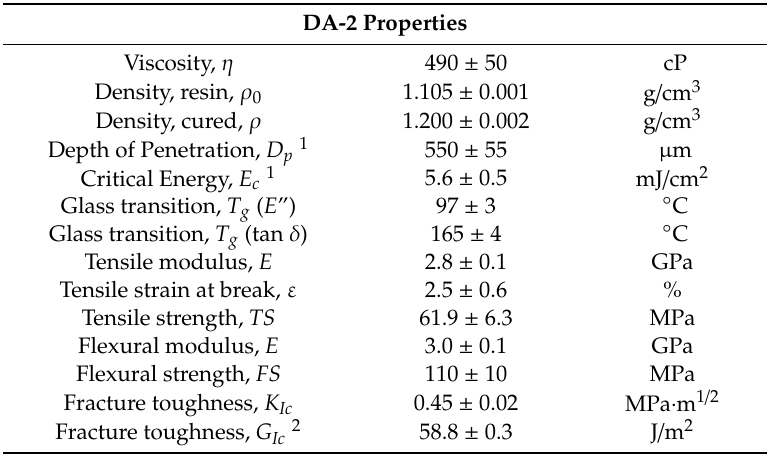
Table 5. DA-2 property